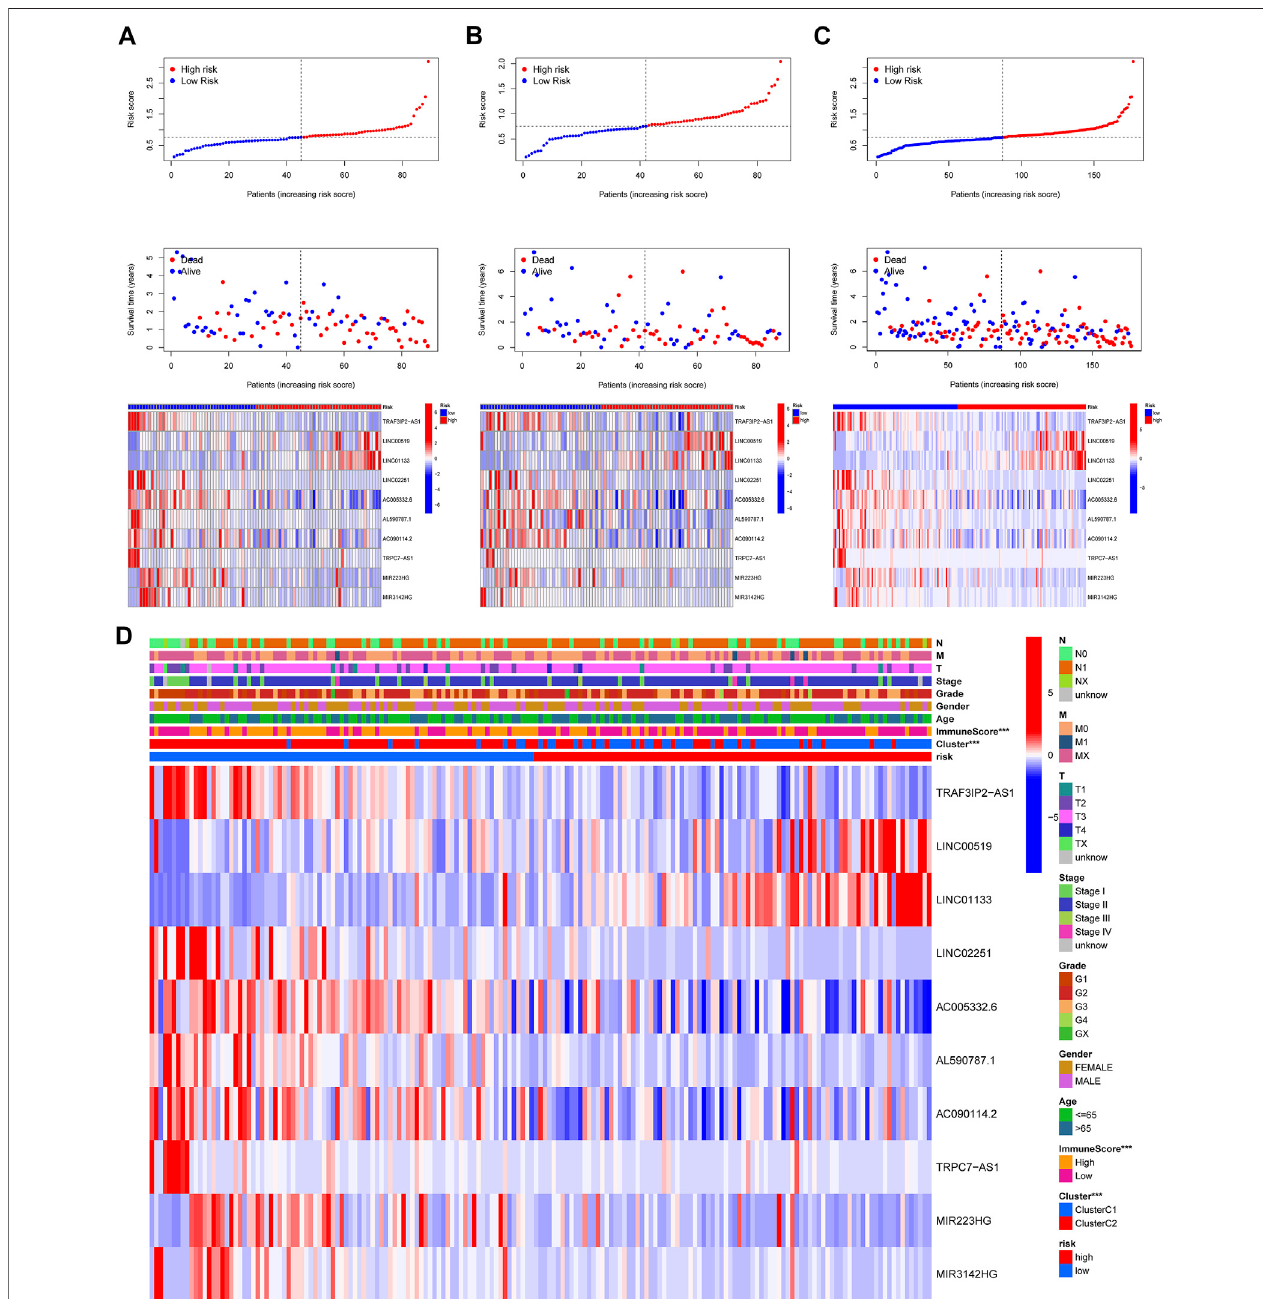
FIGURE 6 | Risk survival status and the connection among risk scores, clusters, and clinical features. (A – C) Patients ’ survival conditions in the training set (left), testing set (middle), and entire dataset (right): risk scores (upper), survival status (middle), and PRlncRNAs levels (below). (D) The connection of the risk score with the clinical characteristics and clusters (*** p <